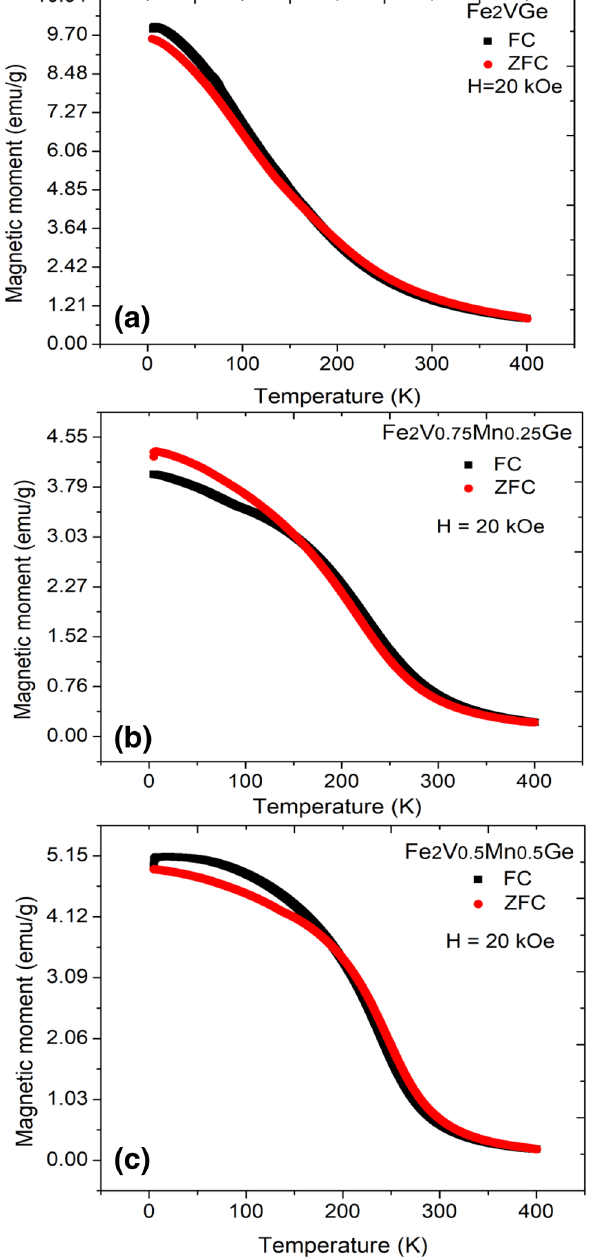
Fig. 8 (M-T) graphs of Fe wide temperature file up to room temperature